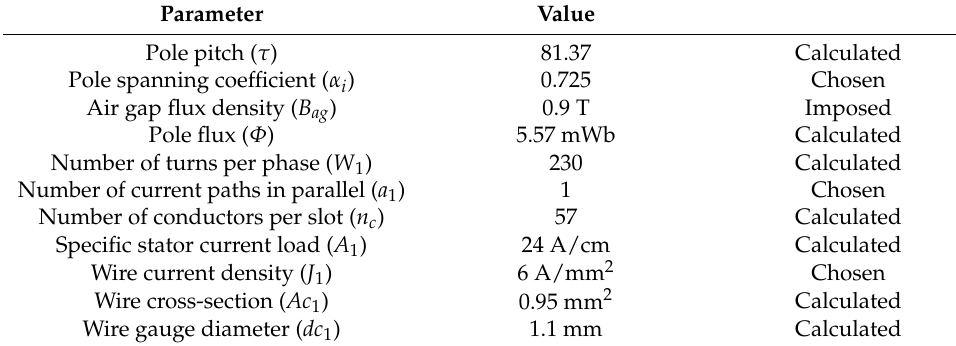
Table 3. Stator coil’s design.